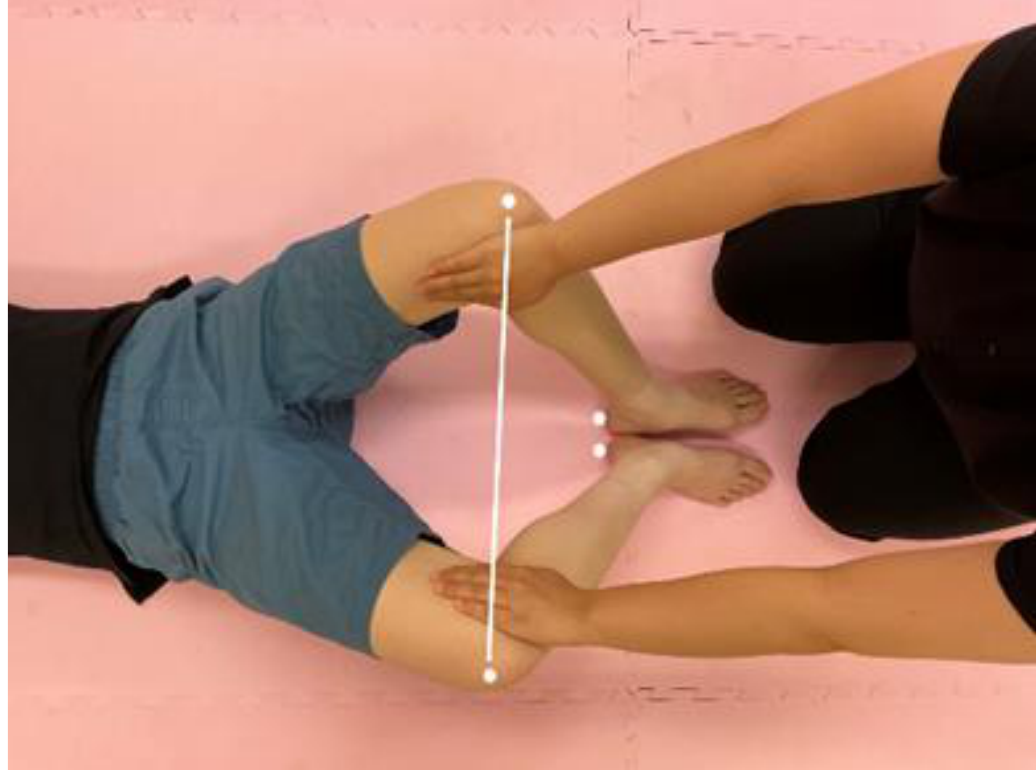
Figure 2. Measurement of hip range of motion. The children were asked to lie in a supine position, and the heel position was fixed to the bed with the hip joint flexed to 45° and the knee joint flexed to 90°. In that state, the hip range of motion was measured while performing the passive hip joint opening and closing exercise.